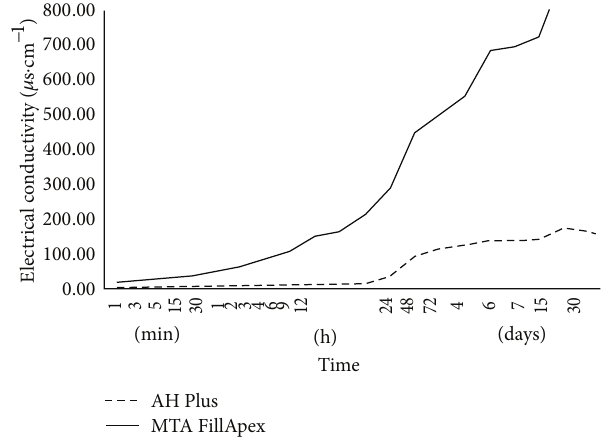
Figure 2: Electrical conductivity ( 𝜇 S/cm −1 ) evaluation according to different periods of